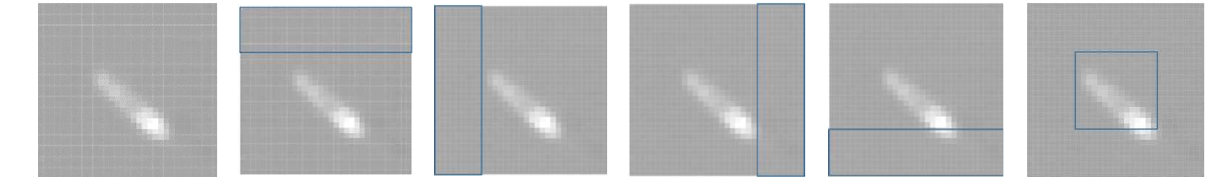
Figure 6. Diagram of six parts ofimage block. From left to right is the global part, the upper part, the left part, the right part, the lower part, and the middle part.